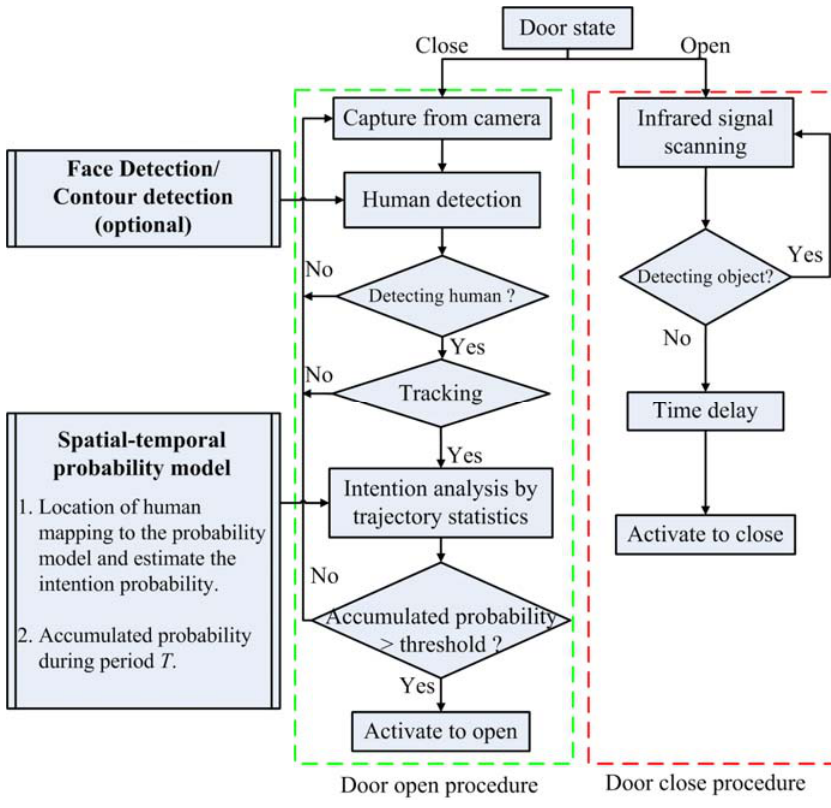
Figure 1. System flowchart.